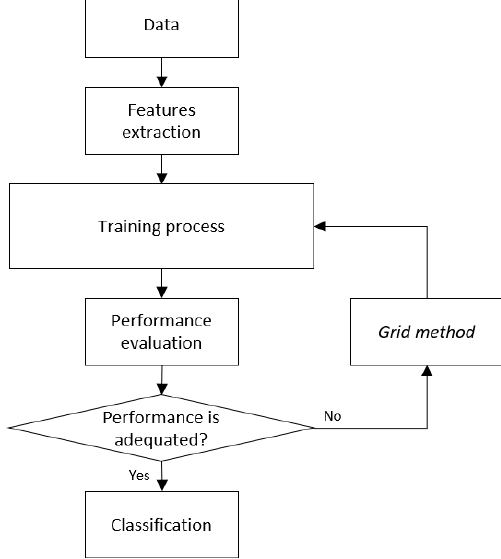
Figure 3. Classification